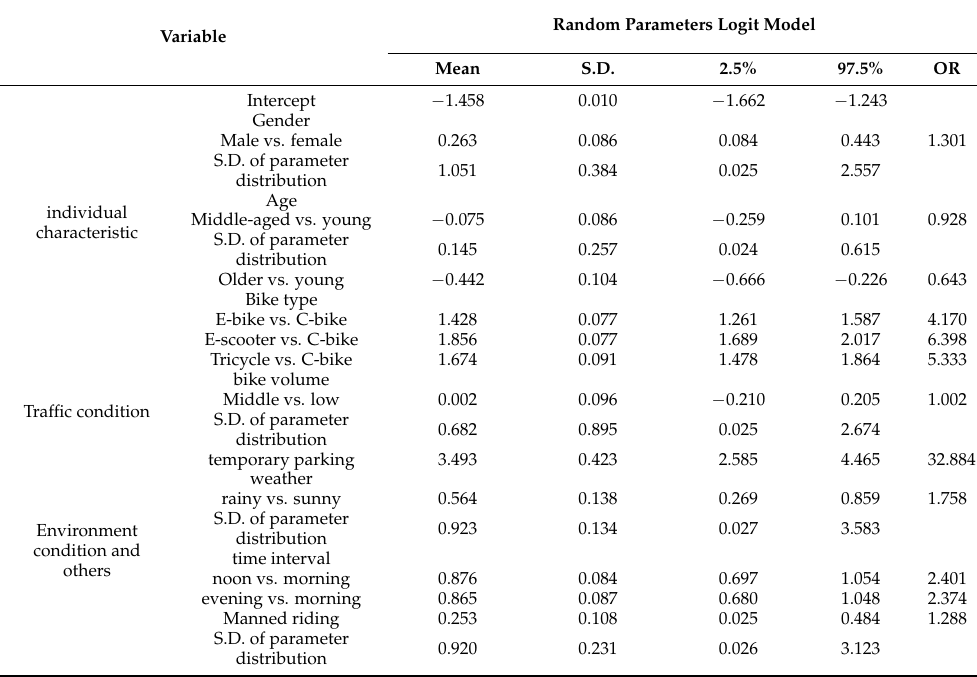
Table 9. Estimation from the Bayesian random parameters logit model in mixed